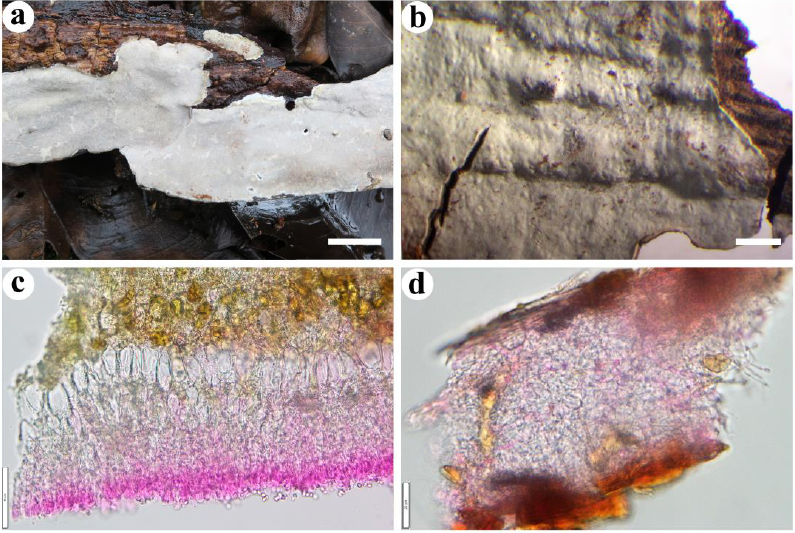
Figure 5. Cystostereum crassisporum (from the holotype BJFC 024259). Scale bars: ( a ) = 1 cm; ( b ) = 1 mm; ( c ) = 50 µm; ( d ) = 20 µm. ( a , b ). Basidiomes; ( c ). Part of a vertical section through basidiome; ( d ). Part of a vertical section from the substrate showing the microbinding hyphae.